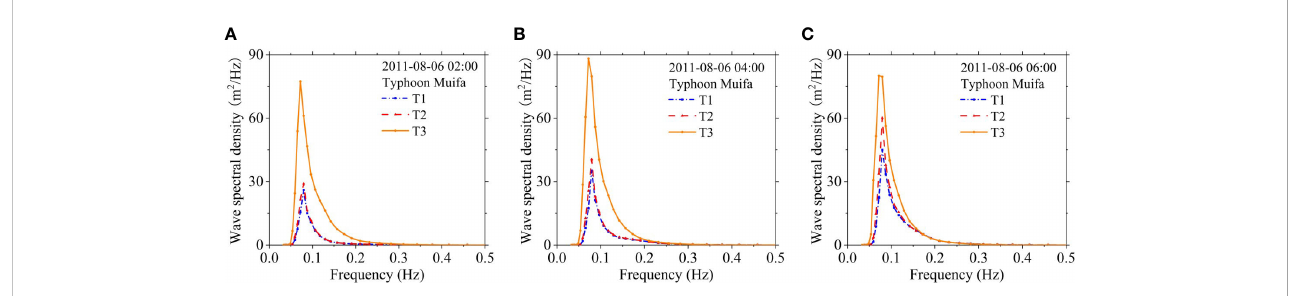
TABLE 3 Comparison of wave spectral density of various wind fi elds during Typhoon Muifa passing by the buoy station.